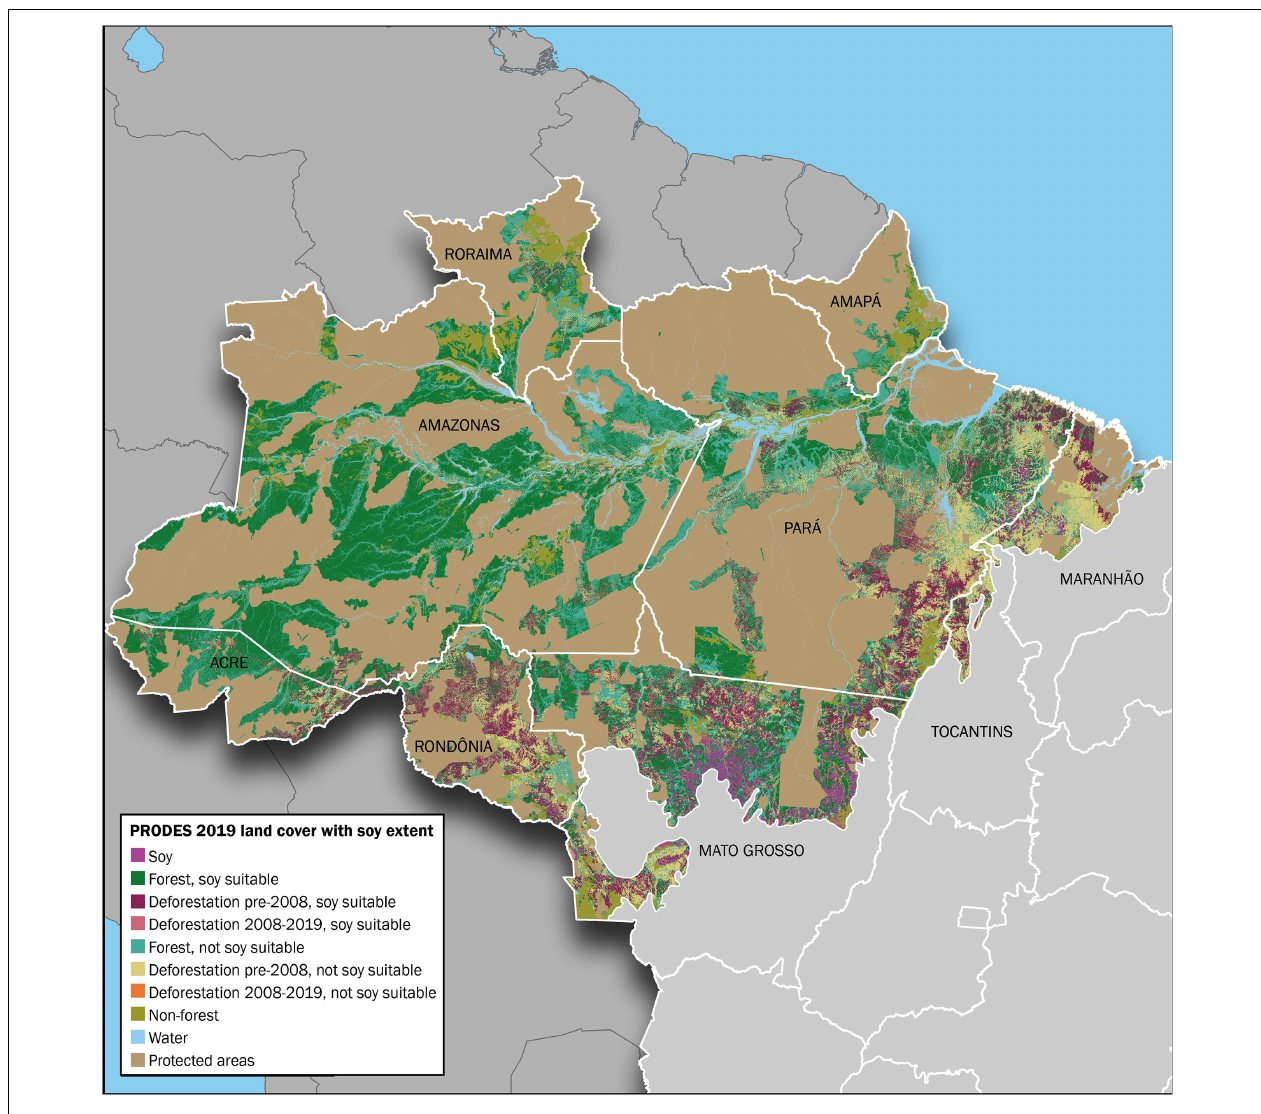
FIGURE 2 | Land cover in the Amazon according to soy suitability.